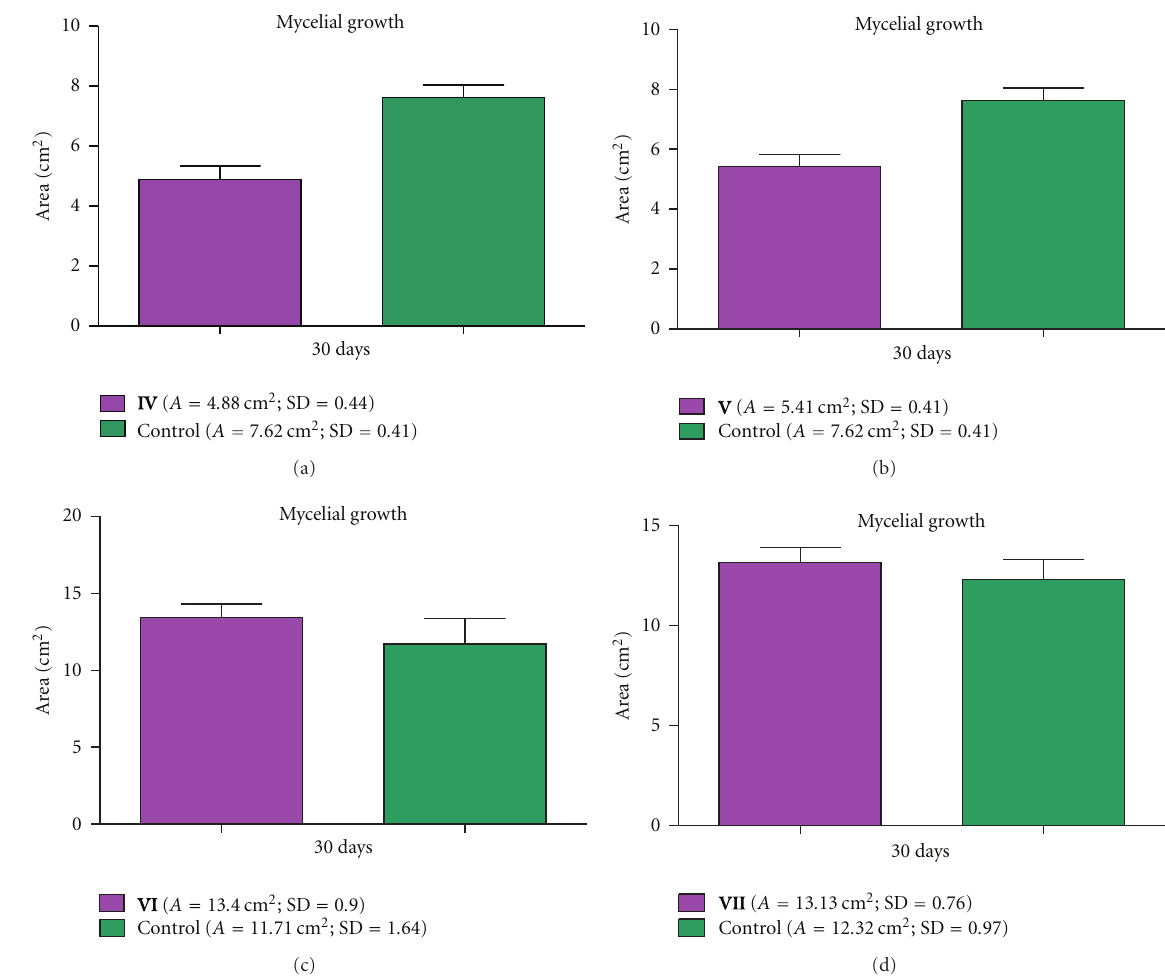
Figure 2: E ff ect of the fractions IV (600 μ g · mL − 1 ), V (600 μ g · mL − 1 ), VI (600 μ g · mL − 1 ), and VII (600 μ g · mL − 1 ) on the mycelial growth of the symbiotic fungus L.